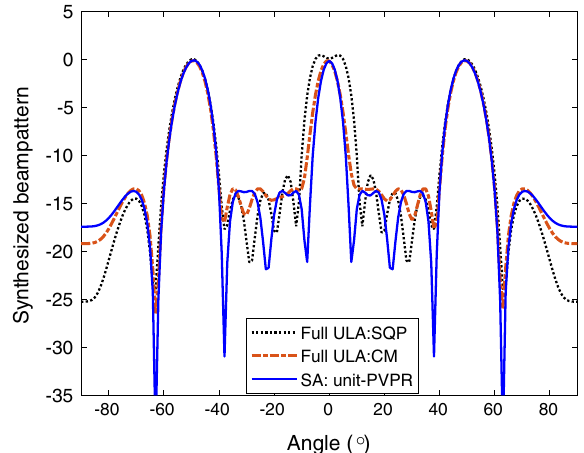
Fig. 5 Focused beampattern comparison of the proposed SA with the full